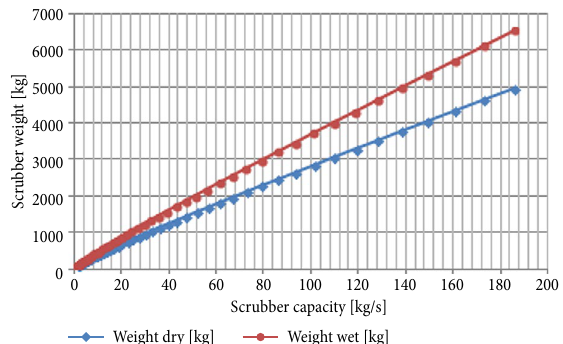
Fig. 2. Scrubber weight per scrubber capacity